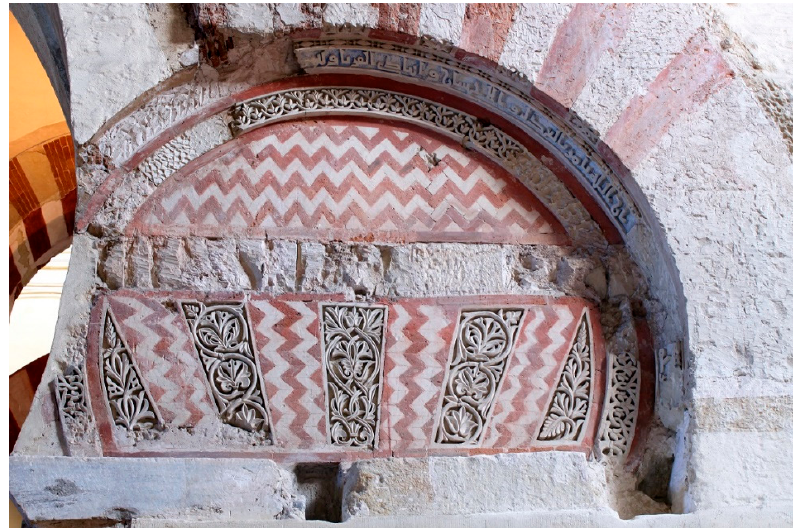
Figure 16. Dirhams of al- Ḥ akam II: 963-964/352H (MANF2008_103_85_P) and 964-965/353 H (MANF2008_103_129_P) coined at the mint of Madinat al-Zahra’. Museo Arqueológico Nacional, Madrid. Photo: María del Mar Gómez Talavera, © In public domain.